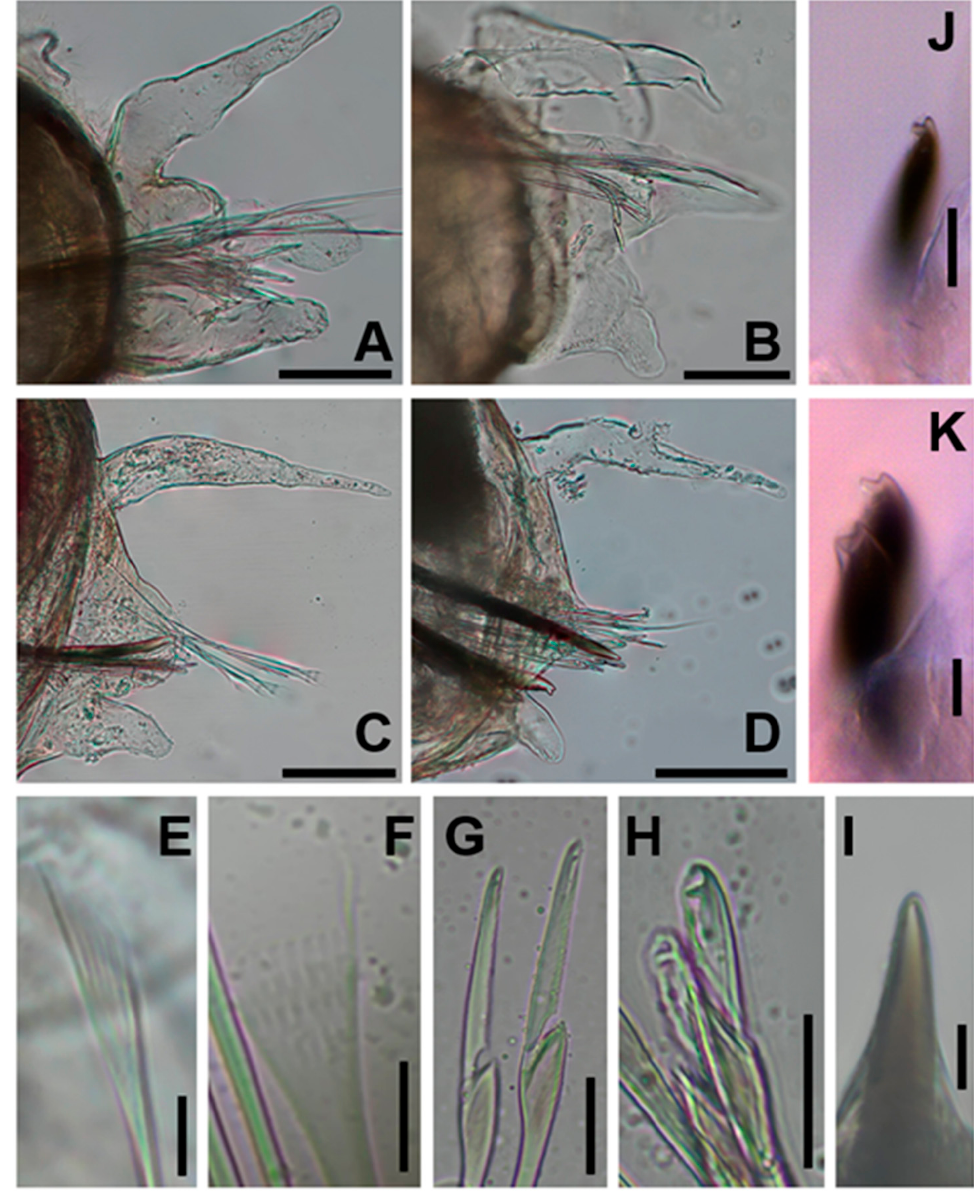
Figure 3. Paucibranchia triantennata sp. Nov: ( A ) parapodium of chaetiger 4; ( B ) parapodium of chaetiger 15; ( C ) parapodium of chaetiger 25; ( D ) parapodium of chaetiger 58; ( E ) isodonts pectinate and narrow with long and slender teeth, chaetiger 3; ( F ) isodonts pectinate and narrow with short and slender teeth; ( G ) compound falciger, long blade, chaetiger 12; ( H ) compound falciger, short blade, chaetiger 61; ( I ) acicula, chaetiger 68; ( J ) subacicular hook, chaetiger 26; ( K ) subacicular hook, chaetiger 39. Scale bars: 100 µ m ( A – D ); 20 µ m ( G , H , J ); 10 µ m ( E , F , H , I , K ). Aciculae are blunt and amber-colored (Figure 3I). Only one acicula presents per chaetiger. Limbate chaetae of two sizes are present in the same chaetiger and larger in the anterior region, reduced in number around chaetiger 22. Two types of pectinate chaetae are present. In the anterior chaetigers, isodonts are narrow with long and slender teeth, with 1–3 pectinate chaetae per chaetiger and up to 5–6 teeth with oblique distal edges (Figure 3E). Median-posterior chaetigers feature narrow isodonts with short and slender teeth, in addition to 4–5 pectinate chaetae per chaetiger and up to 8–10 teeth with oblique distal edges (Figure 3F). Compound spinigers are absent in all chaetigers. Compound falcigers are present in all chaetigers. The anterior region exhibits blades of two